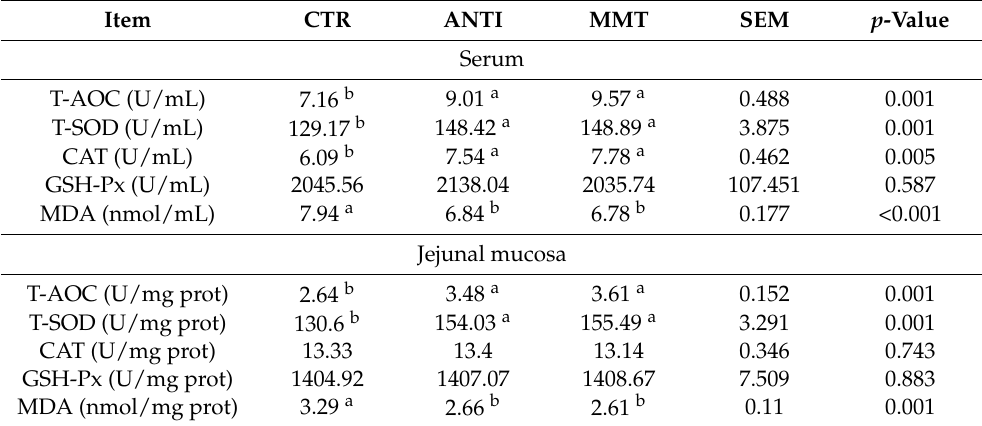
Table 4. Serum and jejunum mucosa antioxidant status of broiler 1 .